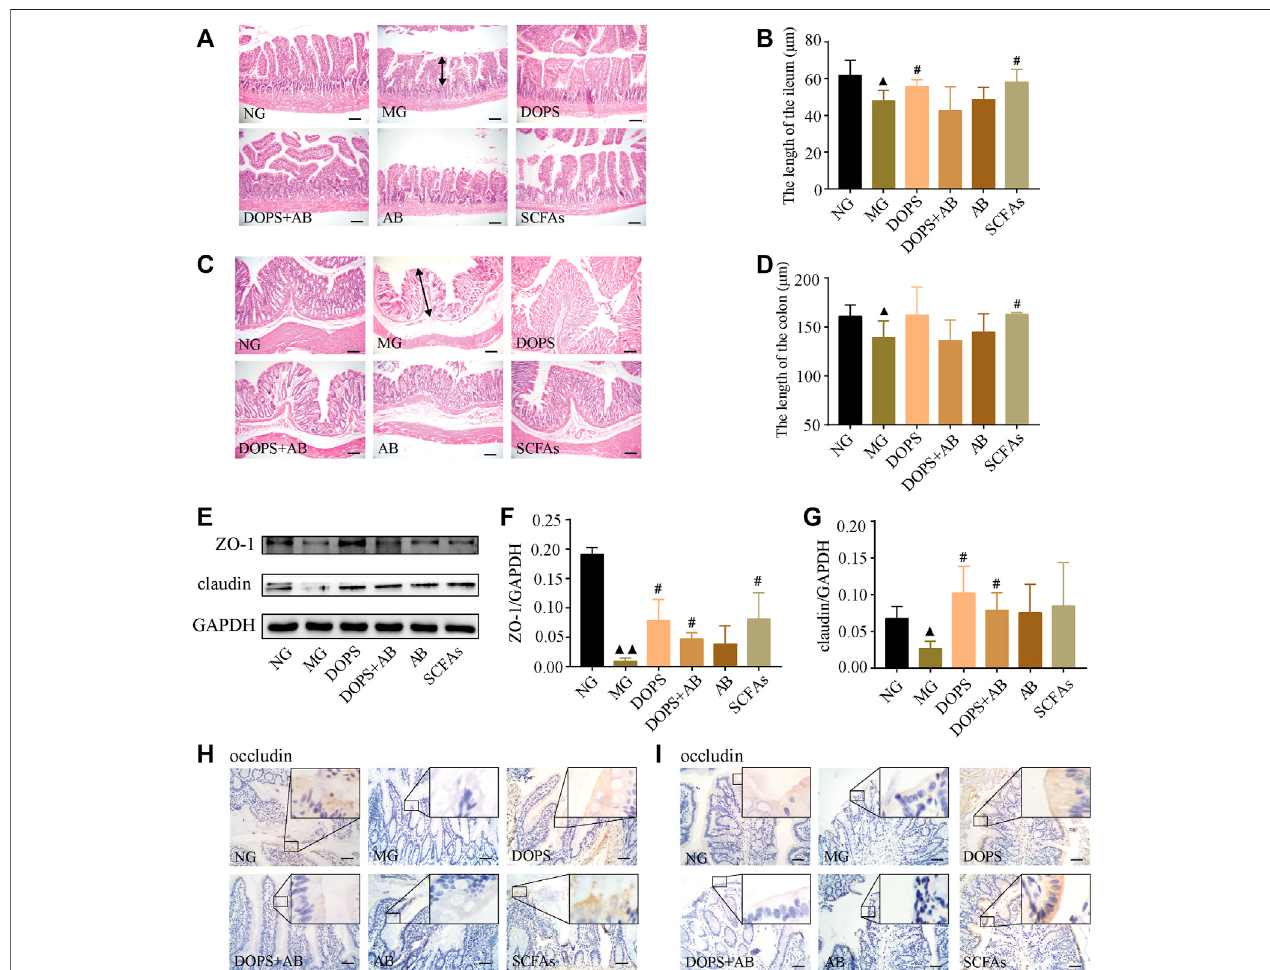
FIGURE 4 | Effect of DOPS on intestinal pathophysiological changes and tight junction barrier in the MH rats. (A – D) Representative graphs of hematoxylin and eosin (H&E) staining and length statistics of the ileum and colon (×200), bar = 100 μ m. The two-way arrows indicate the length of villi in the ileum and colon in the model group,respectively. (E) RepresentativeWBgraphsofZO-1,claudin,andGAPDHinthecolon. (F,G) DatastatisticsoftheexpressionofZO-1andclaudininthecolon( n = 3). (H,I) Representativegraphsofoccludinimmunohistochemicalstainingoftheileumandcolon(×400),bar=50 μ m.NG,normalcontrolgroup;MG,modelcontrol group; DOPS, Dendrobium of fi cinale polysaccharide; DOPS + AB, Dendrobium of fi cinale polysaccharide + antibiotics; AB, antibiotics; SCFAs, short-chain fatty acids. Compared with the normal control group, ▲ p < 0.05 and ▲▲ p < 0.01; compared with the model control group, # p < 0.05 and ## p < 0.01.